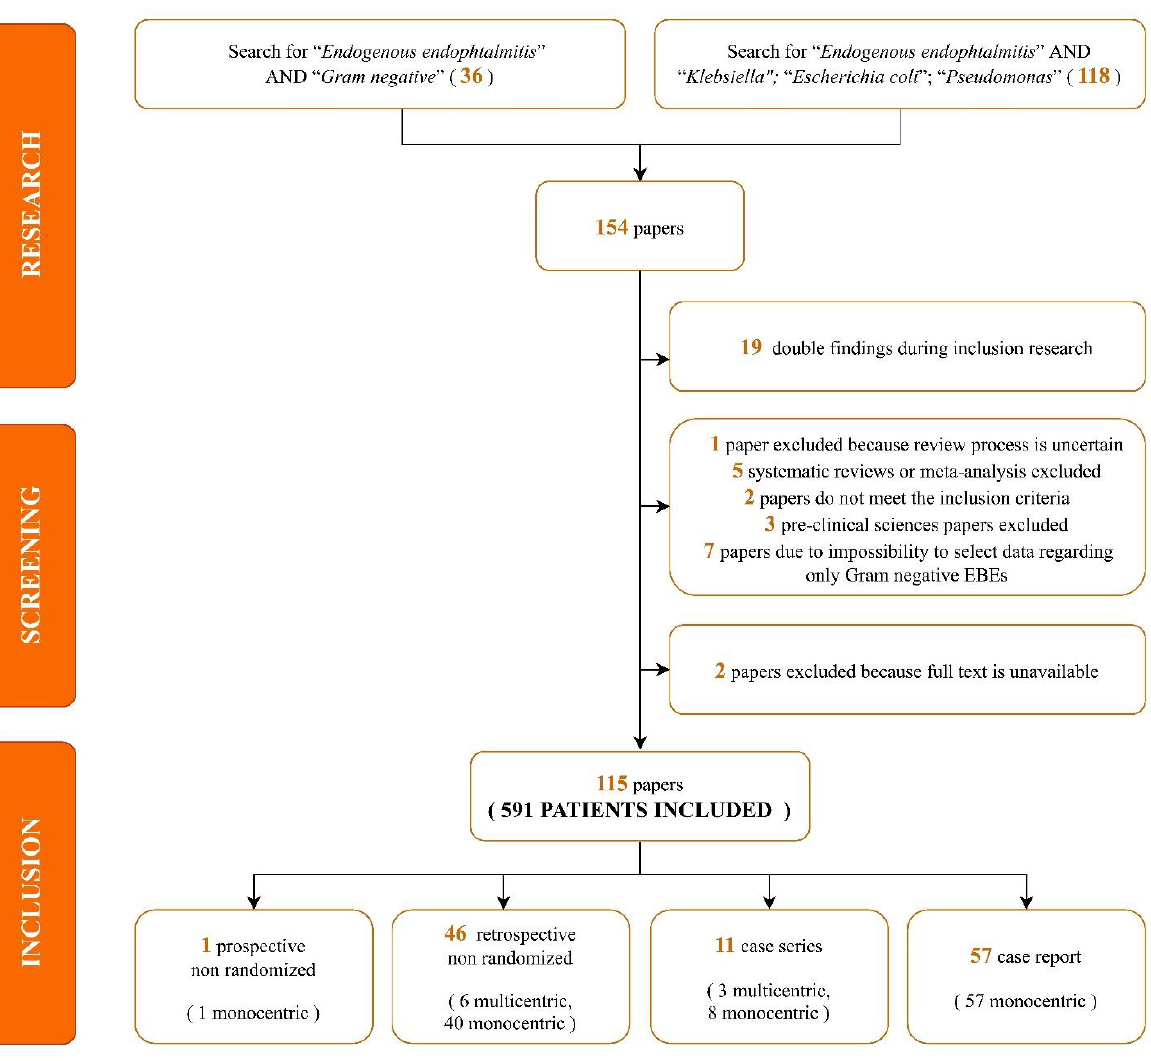
Figure 1. Search strategy and selection process flow-chart.